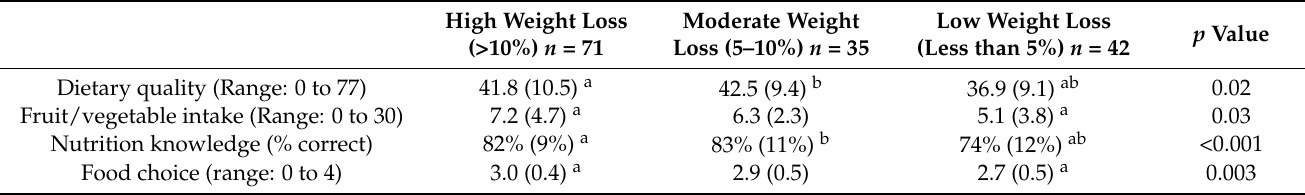
Table 4. Differences in nutritional factors among weight loss groups at 18